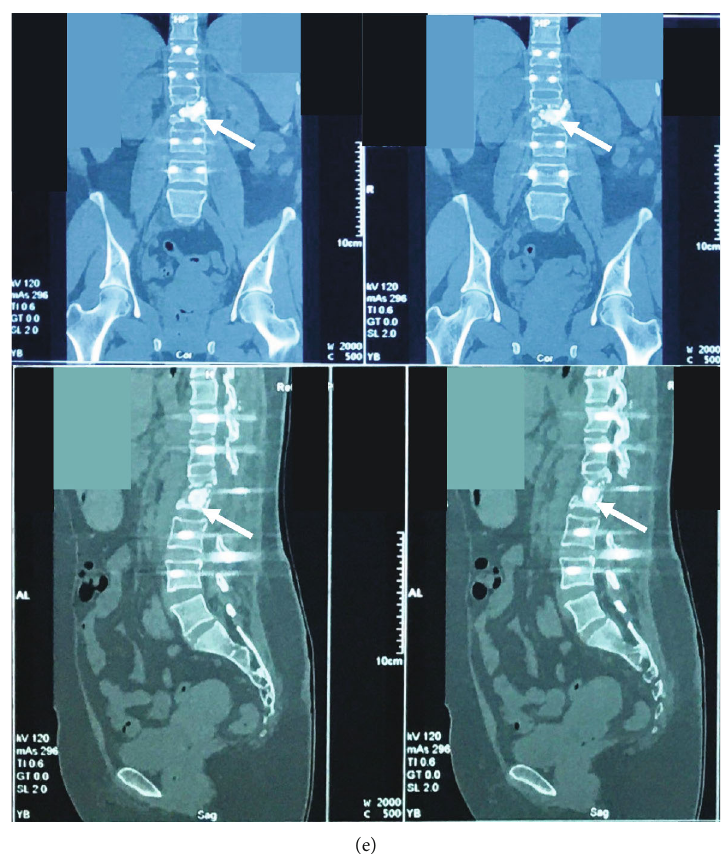
Figure 4: A 29-year-old female (case 1). (a) Preoperative radiography showed large destruction on the corpus vertebrae which causes nonunion and implant failure. (b) Early postoperative radiography showed implant planted posteriorly bridging defected bone with alignment well corrected. (c) Three-month postoperative radiography showed 60% of new bone growth on the defected corpus vertebrae. (d) Six-month postoperative radiography showed 80% of new bone growth on the defected corpus vertebrae. (e) Six-month postoperative CT scan showed 80% of new bone growth fi lling the bone defect especially on the right posterior lateral. Sites are shown using white and black